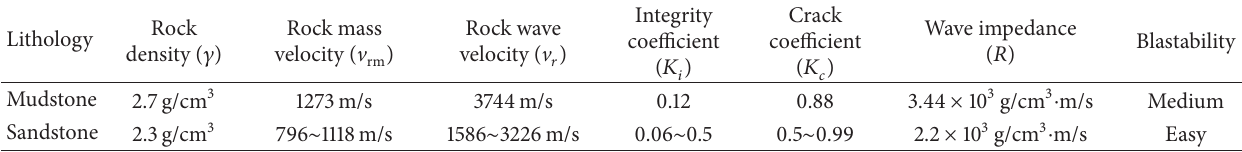
Table 2: Main characteristic parameters of rock stratum in the blasting area. Lithology Mudstone